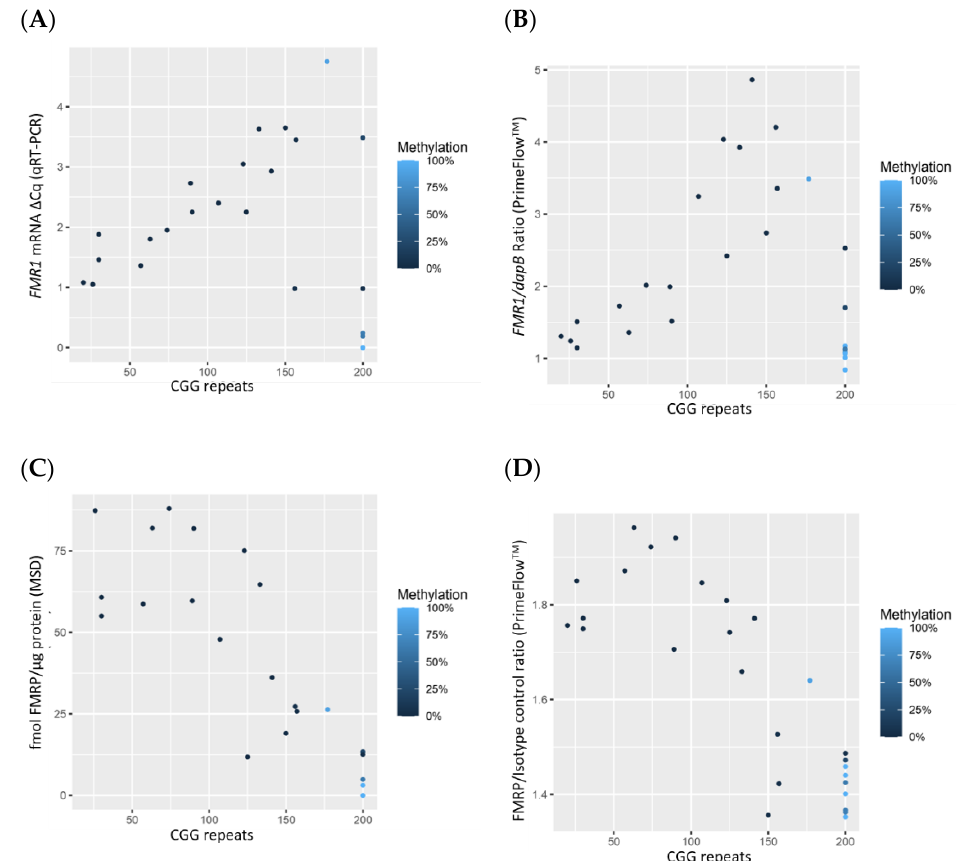
Figure 1. Scatterplots showing a significant positive correlation between CGG repeat length and FMR1 expression levels measured using qRT-PCR ( n = 25) ( A ) and PrimeFlow TM ( n = 27) ( B ). Scatterplot of CGG repeat length versus FMRP expression measured by MSD ( n = 24) ( C ) and by PrimeFlow TM ( n = 27) ( D ). Points are colored by % methylation, with lighter blue corresponding to more methylation and darker blue to less methylation (see Table 1). A small amount of random jitter is applied to the x-axis in order to better display overlapping points.